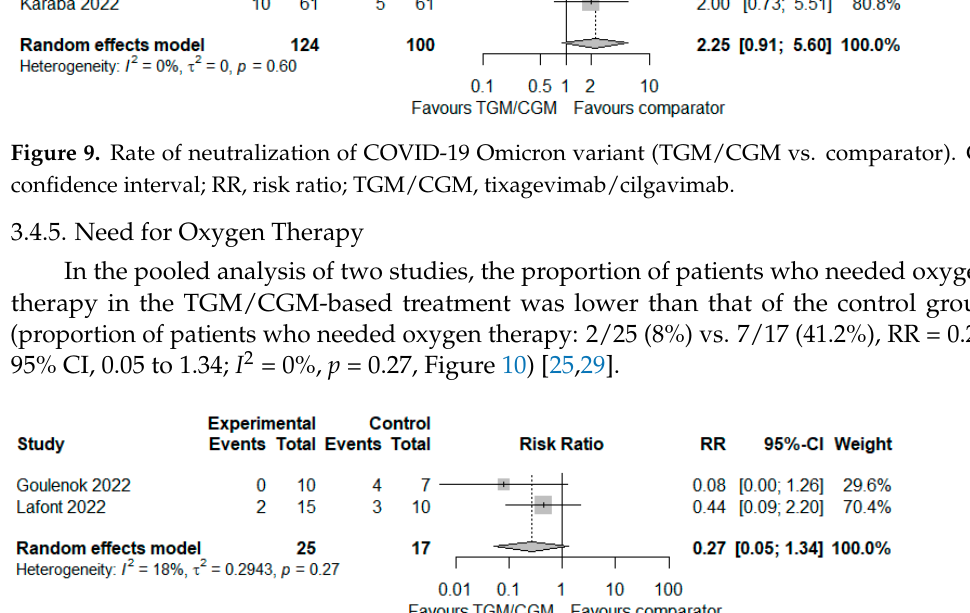
Figure 11. Rate of RT PCR SARS-CoV-2 positivity (TGM/CGM vs. comparator). CI, confidence in- terval; RR, risk ratio; TGM/CGM, tixagevimab/cilgavimab. 3.4.7. Severity of COVID-19 In the pooled analysis of two studies, the proportion of patients who experienced severe COVID-19 in the TGM/CGM-based treatment was lower than that of the control group (proportion of patients who experienced severe COVID-19: 0/3470 (0%) vs. 9/1744 (0.5%), RR = 0.06; 95% CI, 0.01 to 0.45; I 2 = 0%, p = 0.79, Figure 12) [9,25]. Figure 12. Proportion of patients who experienced severe COVID-19 (TGM/CGM vs. comparator). CI, confidence interval; RR, risk ratio; TGM/CGM, tixagevimab/cilgavimab.